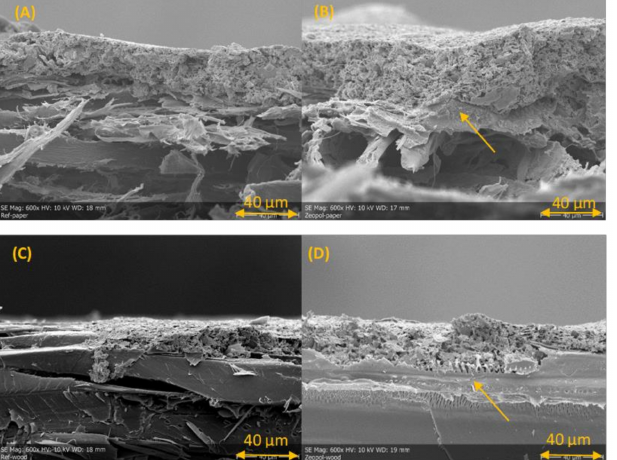
Figure 5. SEM images of cross-cut samples of CB_ref. ( A ), CB_Z33 ( B ), veneer_ref. ( C ) and veneer_Z33 ( D ) with printed silver on the surface. Arrows in images ( B , D ) show the location of the Z33 layer. Image C shows the edge of the printed silver